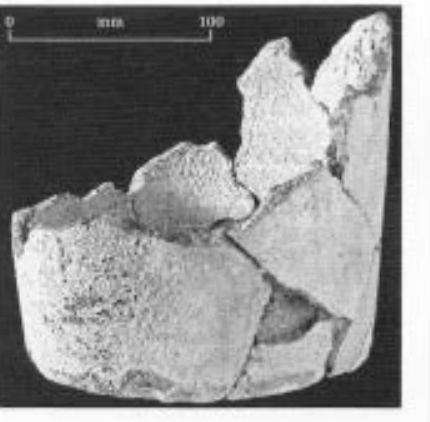
A reconstructed crucible from